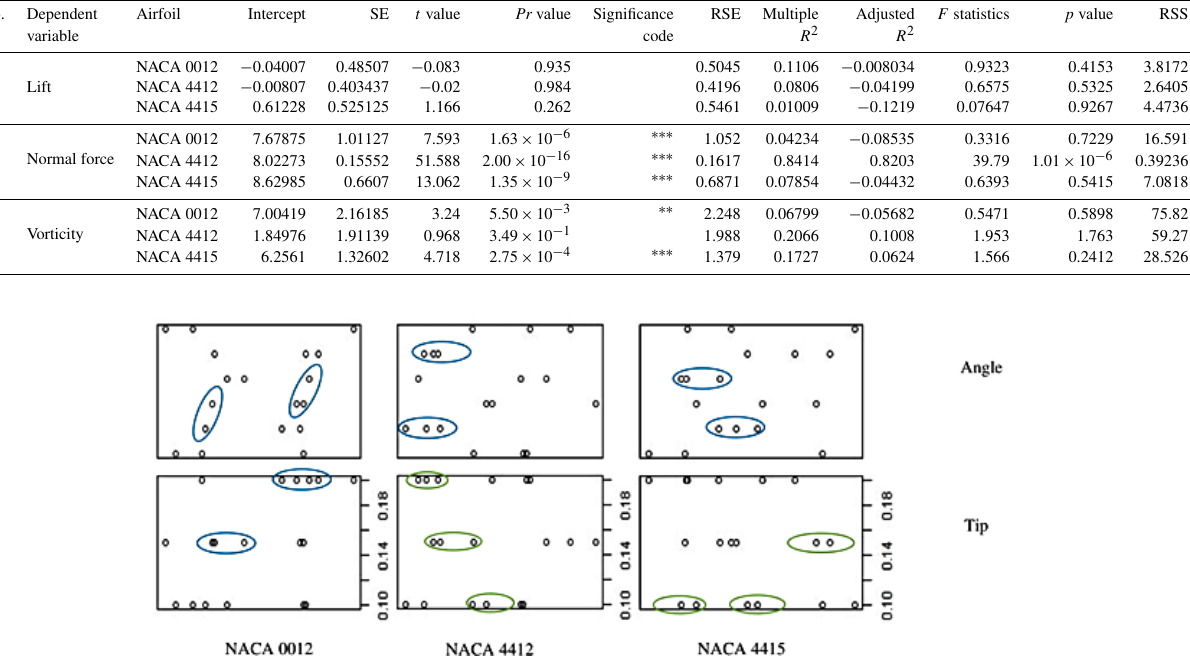
Table 8. The coefficients of dependent variables lift, normal force, and vorticity. The significance codes are shown as follows: ∗∗ 0.001, ∗∗∗ 0.